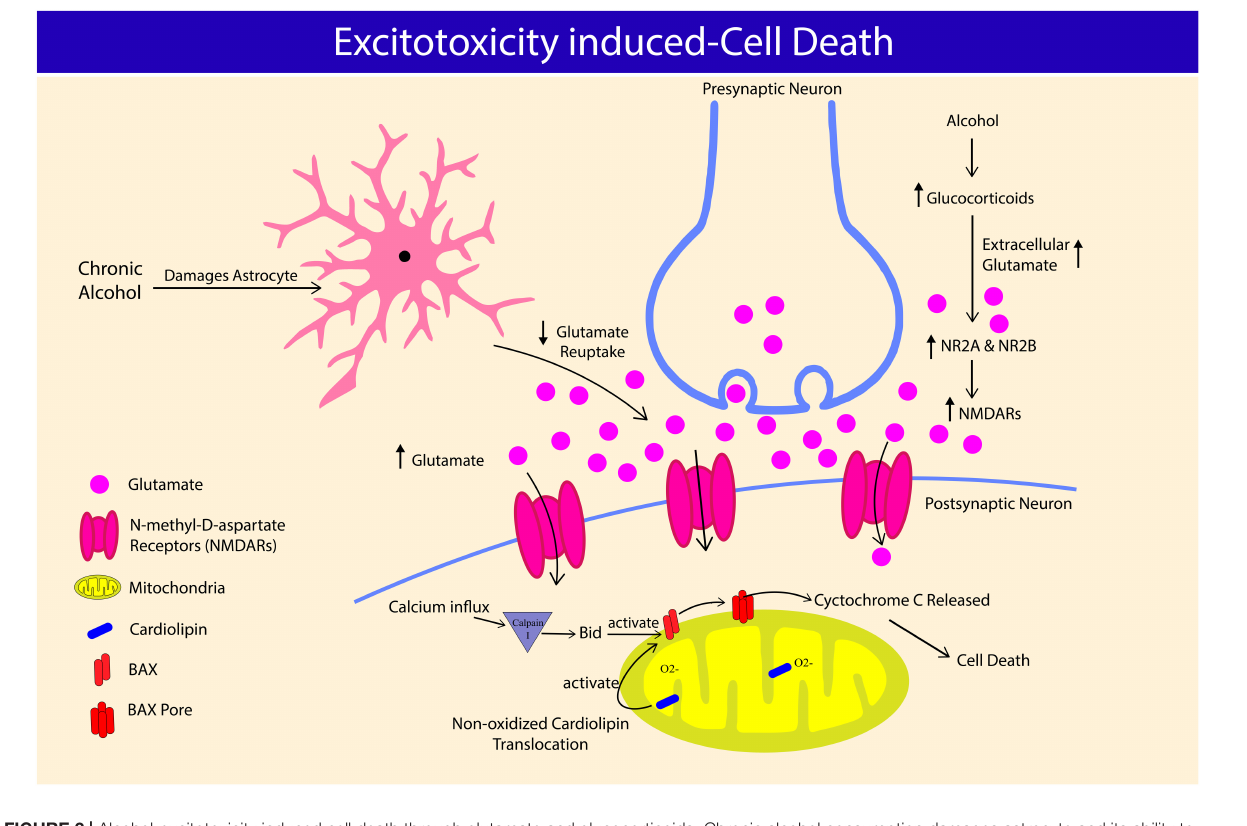
FIGURE 2 | Alcohol-excitotoxicity induced cell death through glutamate and glucocorticoids. Chronic alcohol consumption damages astrocyte and its ability to regulate extracellular glutamate concentration, leading to hyperglutamatergic excitotoxicity. Chronic alcohol consumption increases glucocorticoids level, further elevating extracellular glutamate concentration. Alcohol-induced glucocorticoids also worsen alcohol-excitotoxicity induced cell death by increasing N-Methyl-D-aspartate receptors (NMDARs) and its subunit expression, NR2A and NR2B. NMDARs overactivation causes calcium influx and causes cardiolipin translocation, leading to B-cell lymphoma-2-associated X (BAX) pore formation on mitochondria, which releases cytochrome c causing neuronal cell